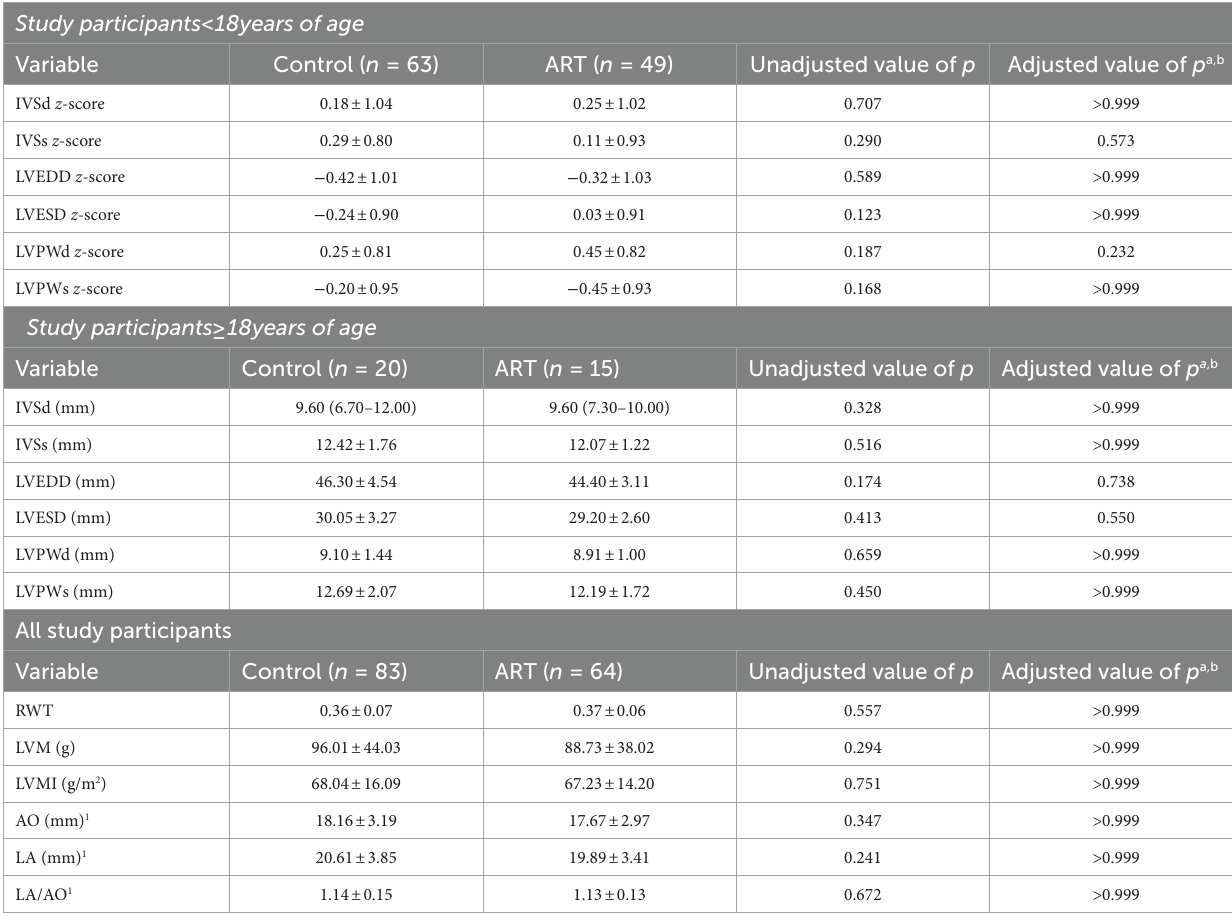
TABLE 2 Left ventricular morphometry assessed by M -mode